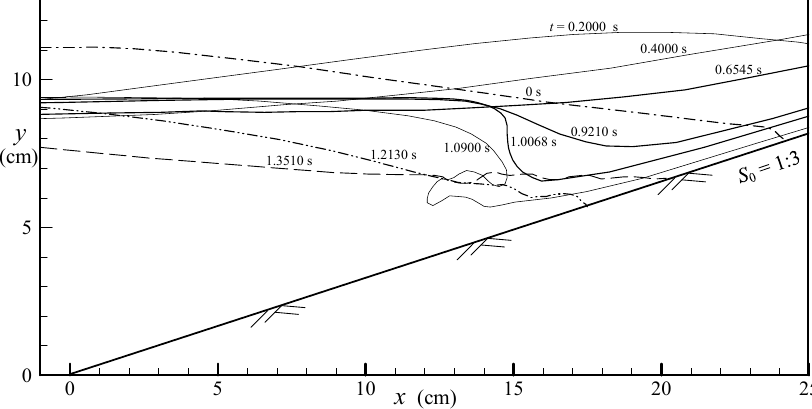
Figure 2. Spatio-temporal variation of the free surface profile for 0 s ≤ t ≤ 1.3510 s (0 ≤ T ≤ 14.96).